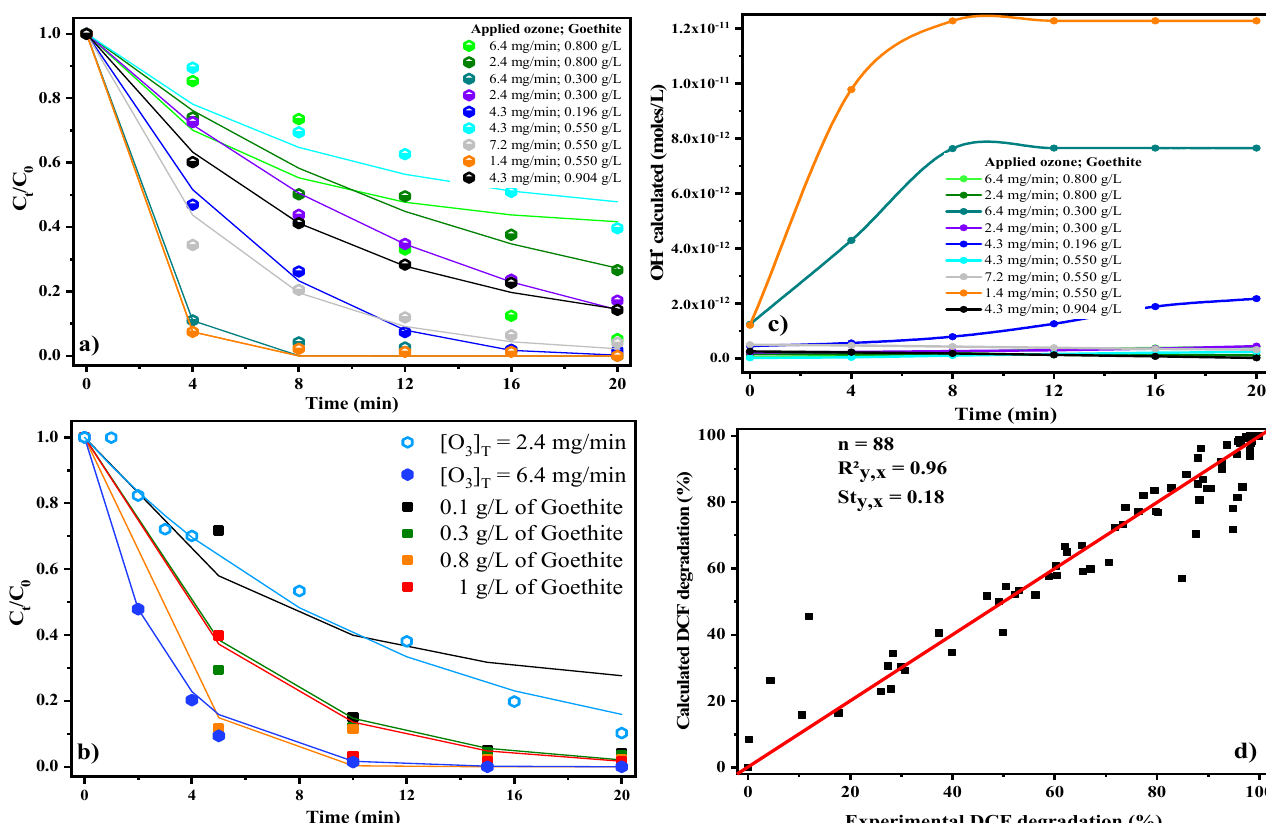
Figure 4. Prediction of experimental data using the SSA kinetic model for ozonation and catalytic ozonation ( a , b ), moles of OH • calculated (by SSA) ( c ), and correlation of experimental and calculated data ( d ). The percentage correlation (R 2 = 0.96) and percentage standard deviation (St y,x = 0.18)